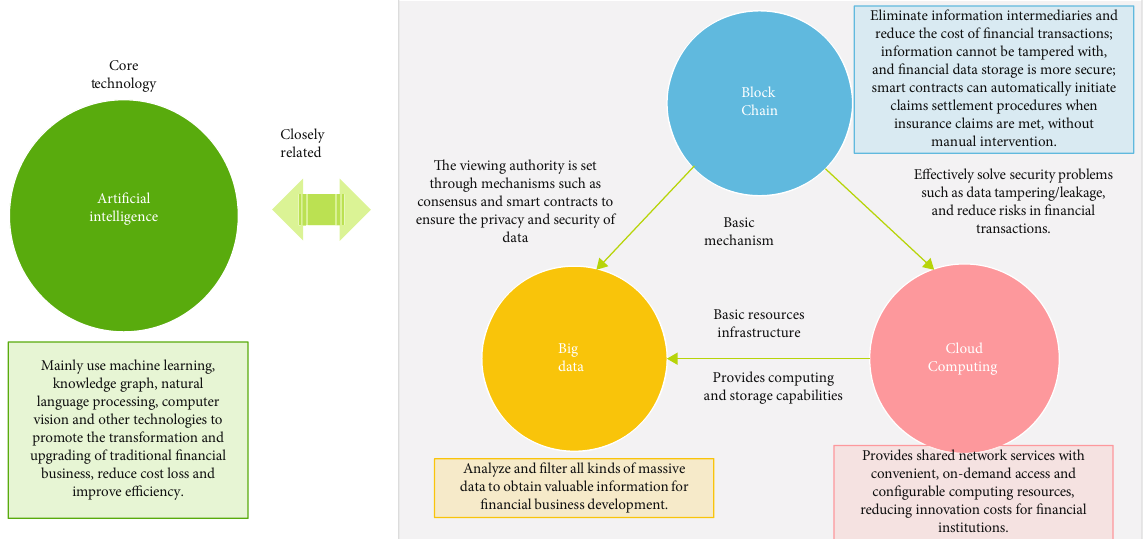
Figure 4: The relationship between AI + fi nancial industry